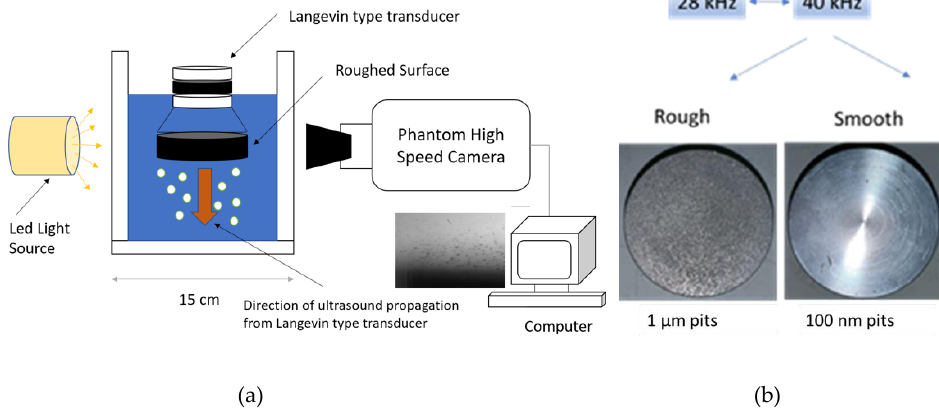
Figure 1. Description of experimental setup and mountable surfaces: (a) Schematic representation of the experimental setup; (b) Mountable surfaces with different surface roughness values.